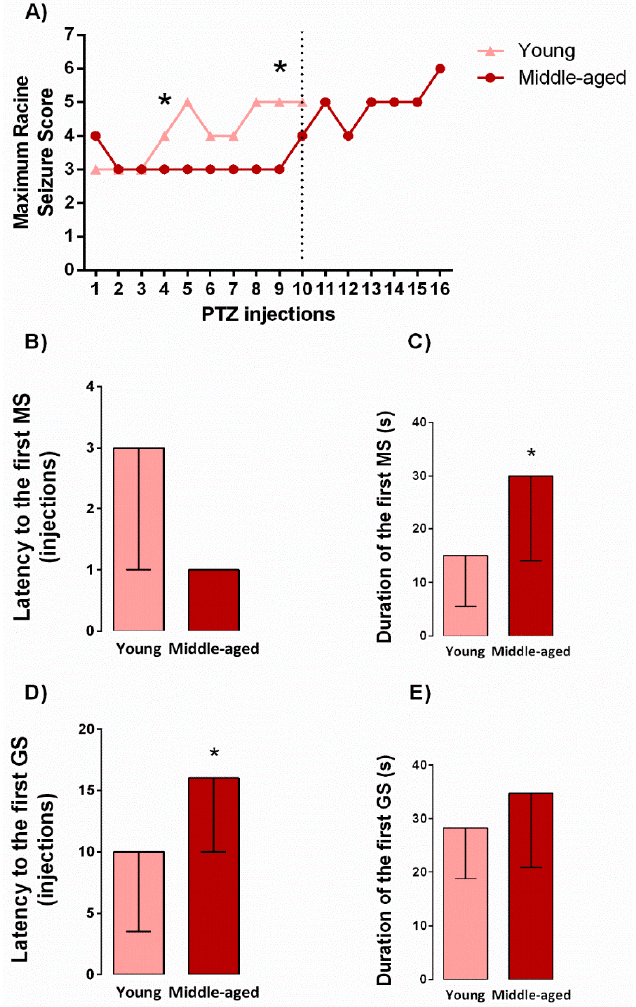
Figure 1. Effects of aging in the maximum racine seizure score during kindling progression. Dashed line delimits the number of injections applied to young rats ( A ). Latency and duration to the first myoclonic (MS) and generalized (GS) seizure ( B – E ). Values are represented by the median followed by Kruskal-Wallis ANOVA ( A ) or median ± interquartile range followed by Mann-Whitney U test (B–E). * p < 0.05 in the comparison between kindled groups ( n = 11–17/group).